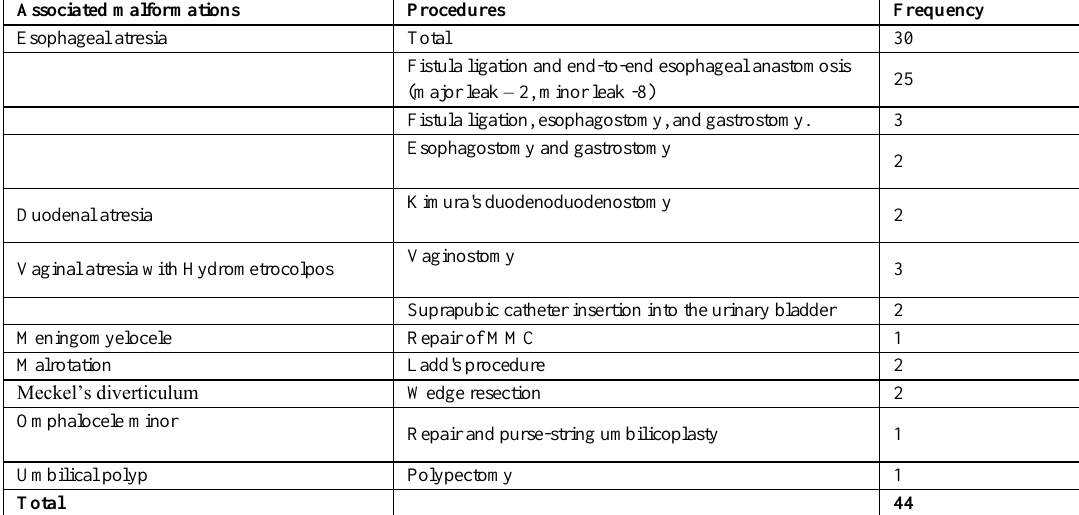
Table 5: Summary of procedures for various associated malformations in the present